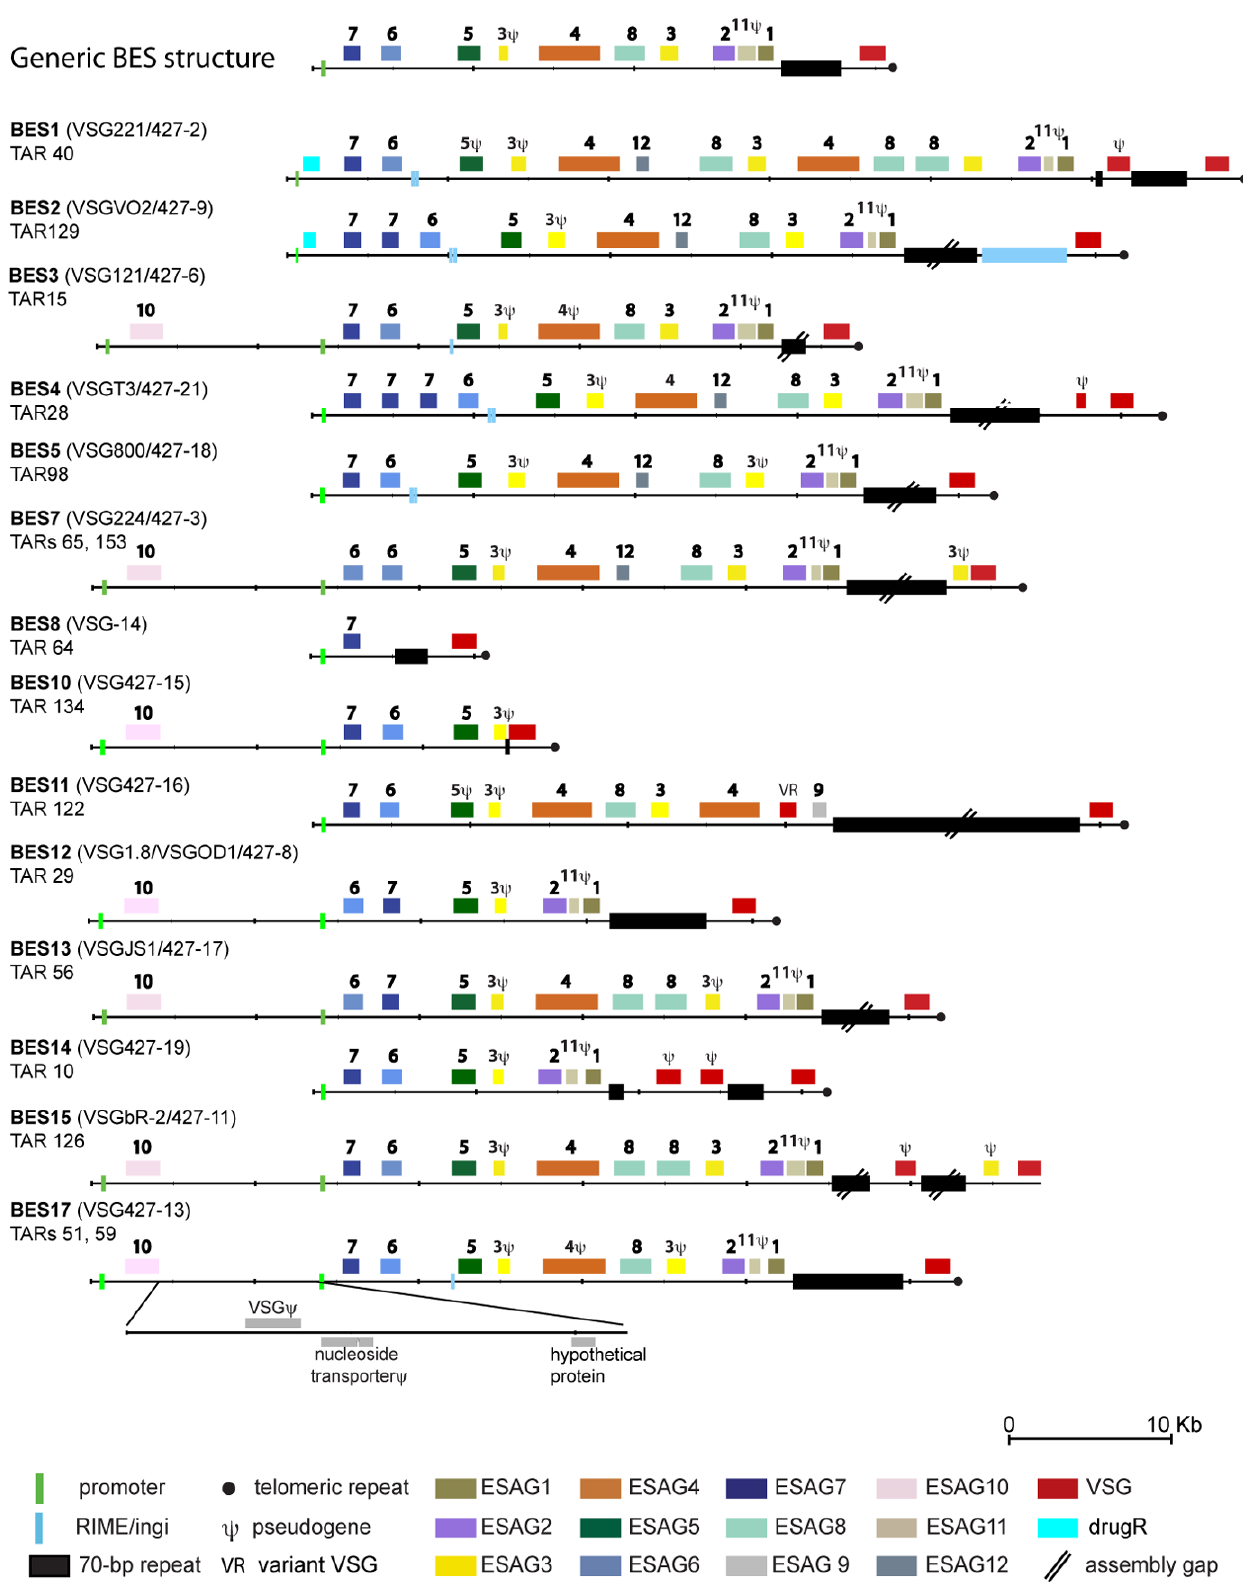
Figure 3. Overview of T.brucei Lister 427 BES. BES are drawn to scale and have been aligned at their 5 9 -most ESAG7 or ESAG6 sequence. The inset shows the regions conserved between the dual promoters present in some of the clones. The VSG indicated in front of the BES label refers to the telomere-proximal VSG . doi:10.1371/journal.pone.0003527.g003 PLoS ONE |